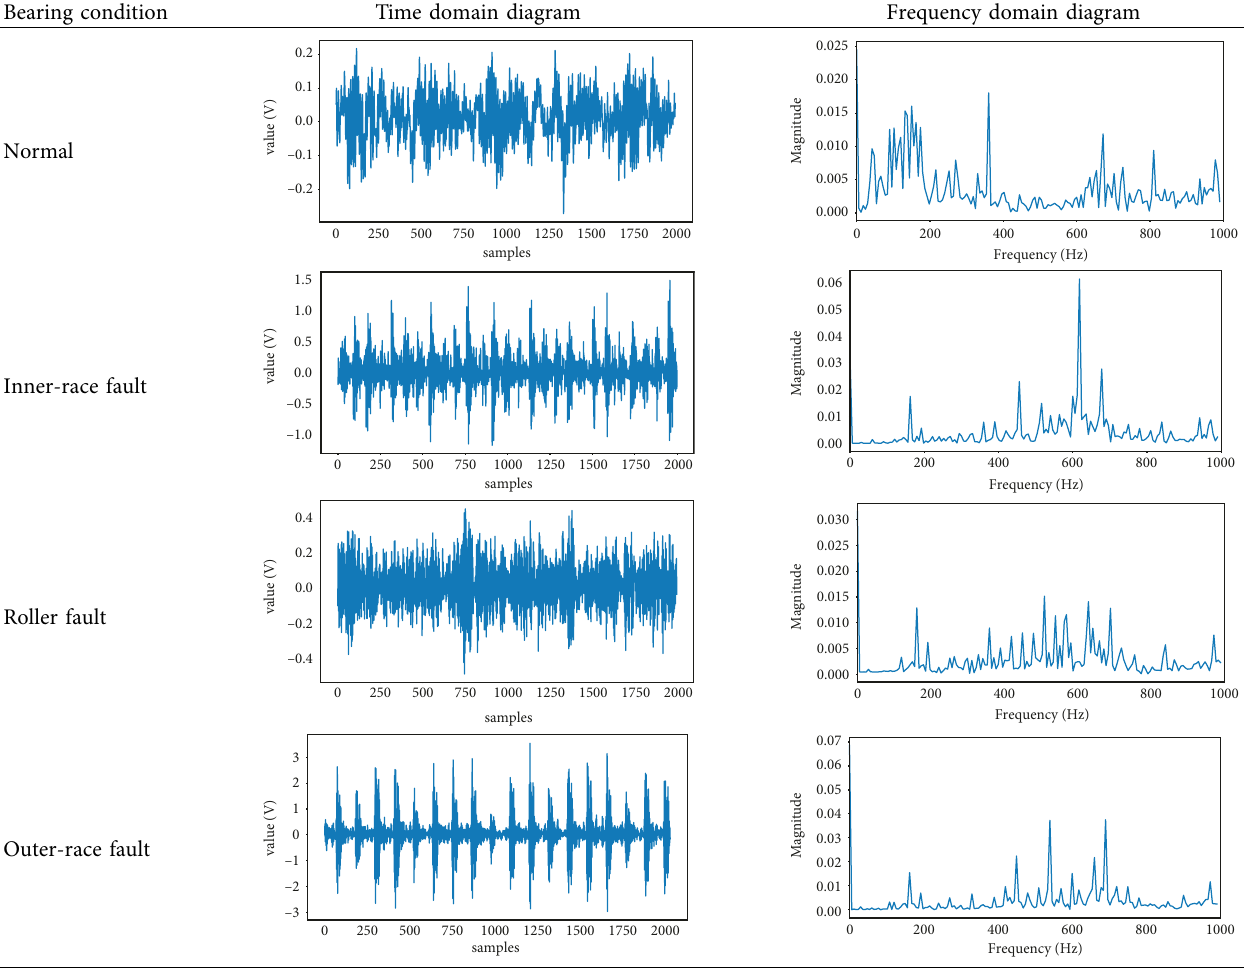
Table 1: Comparison of time domain and frequency domain results of bearings in different conditions. Bearing